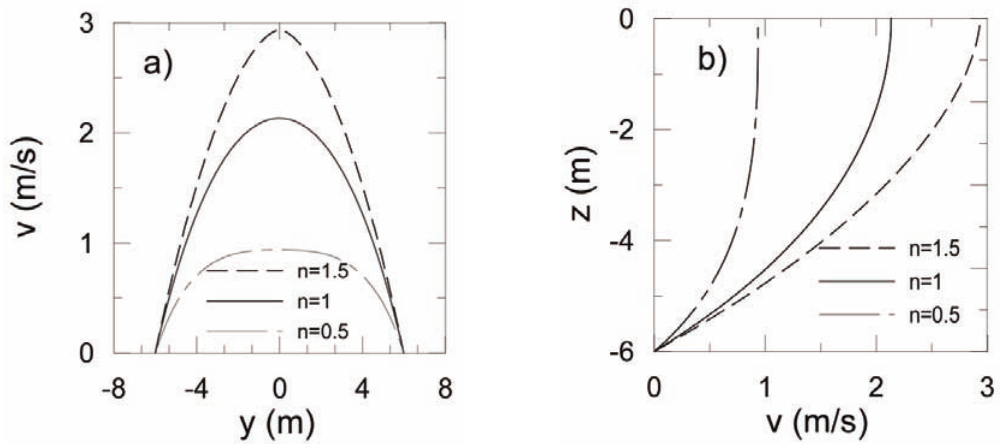
Figure 3. Velocity profiles of the Laghetto channel (Mount Etna, 2001). a) Horizontal profiles at z = 0. b) Vertical profiles, at y = 0. The velocity profiles are plotted for three different values of the power-law exponent n (0.5, 1, 1.5). The parameters of the Etna channel are: a = 12 m, h = 6 m, a = 5˚ (data from Ferlito and Sievert [2006]); the parameters of the lava are: t = 2030 kg m −3 and k = 8625 Pa s n (data from Pinkerton and Sparks [1978]).